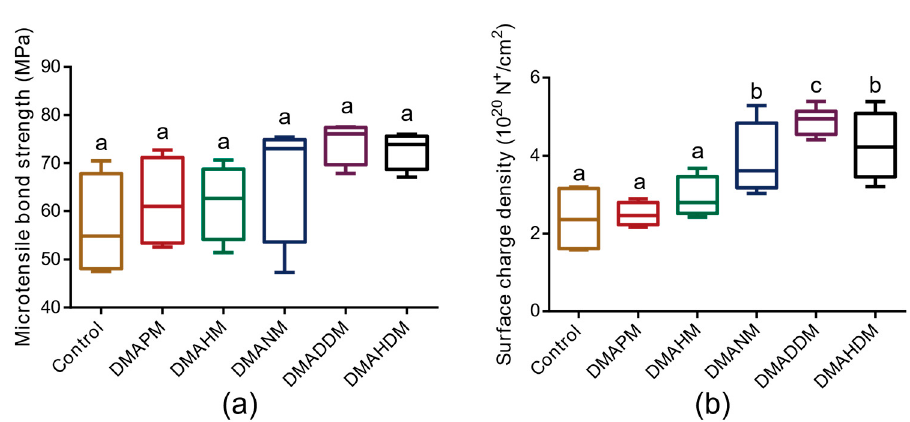
Figure 2. The physical properties of cured adhesives. ( a ) The micro-tensile bond strength ( n = 4); and ( b ) the surface charge density ( n = 12) of adhesives. Bars with the same letter indicate a value having no significant distance, and those with different letters indicate a significant difference ( p < 0.05).